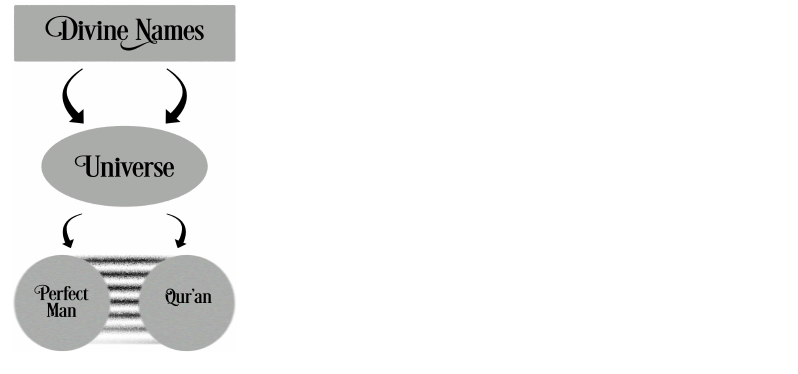
Figure 2. The divine Names as the Universe, the Perfect Man, and the Qur’an. Figure 1. The divine Names as the Universe, the Perfect Man, and the